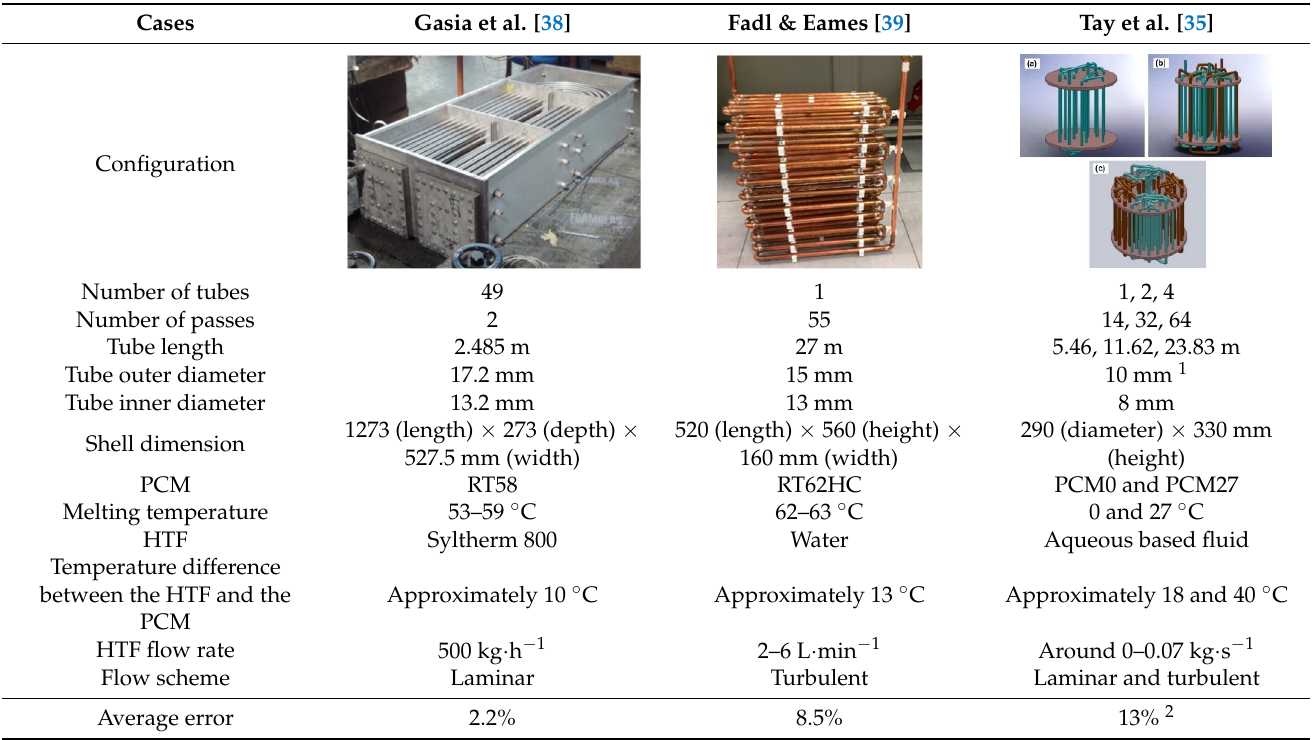
Table 5. Average absolute error and key parameters of experimental cases used to validate the ε -NTU. Cases